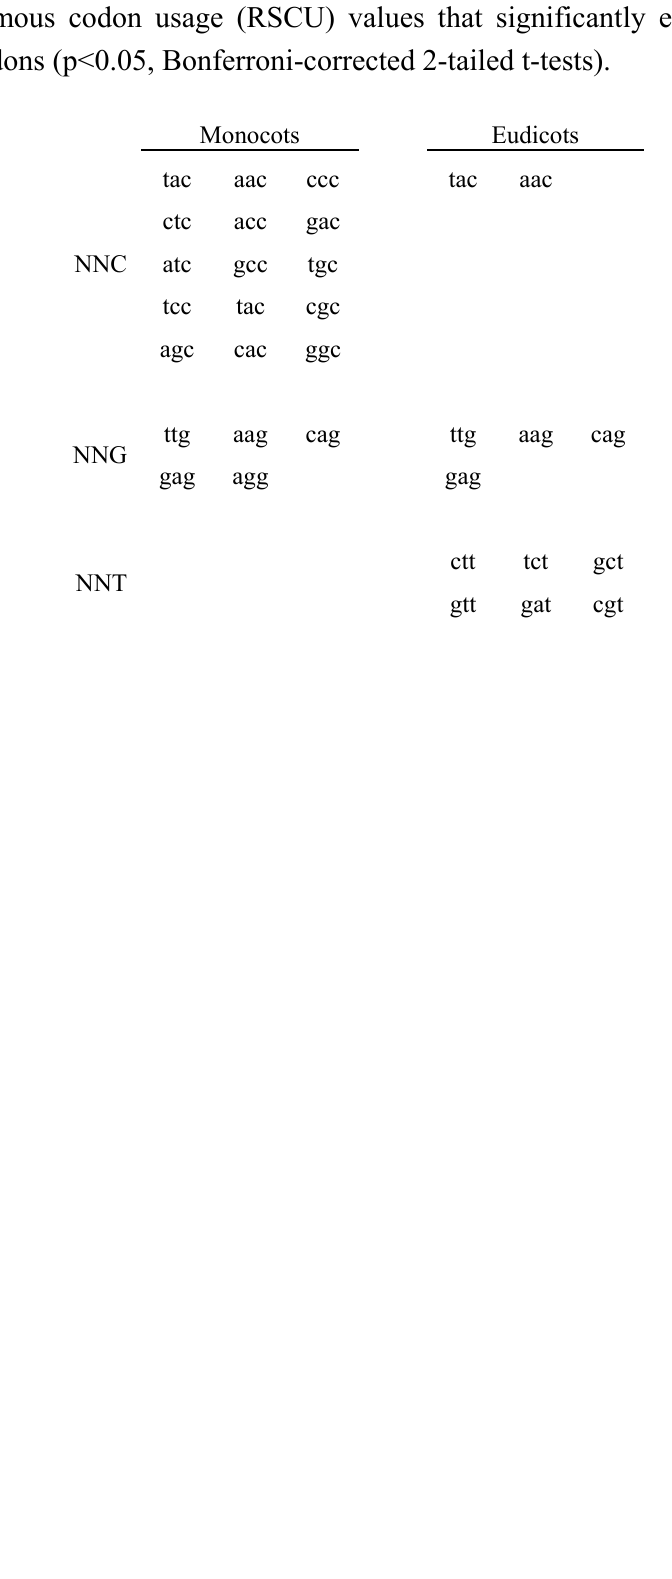
Table 2. Preferred codons in monocots and eudicots. Preferred codons are those with relative synonymous codon usage (RSCU) values that significantly exceed those of